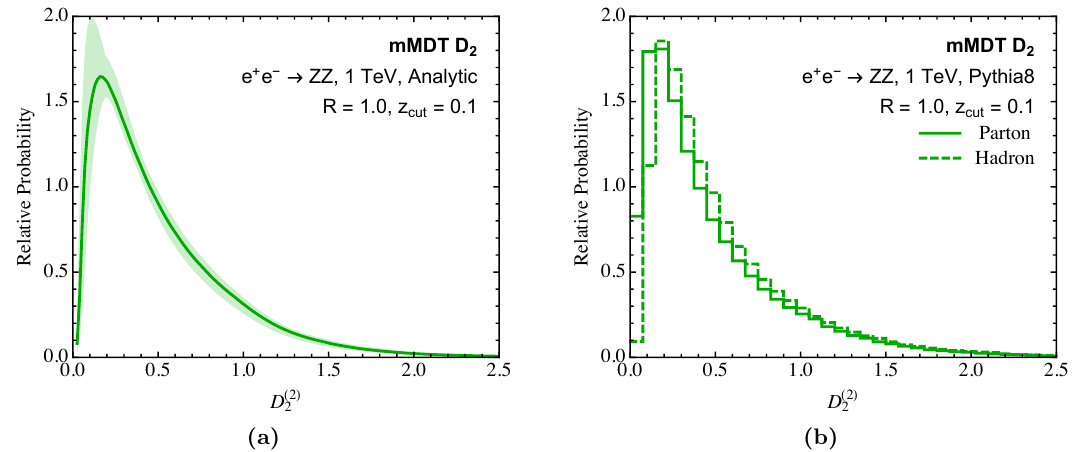
Figure 14. A comparison of the analytic D (2) shower Monte Carlo distribution (right). A mass cut of m J agreement is